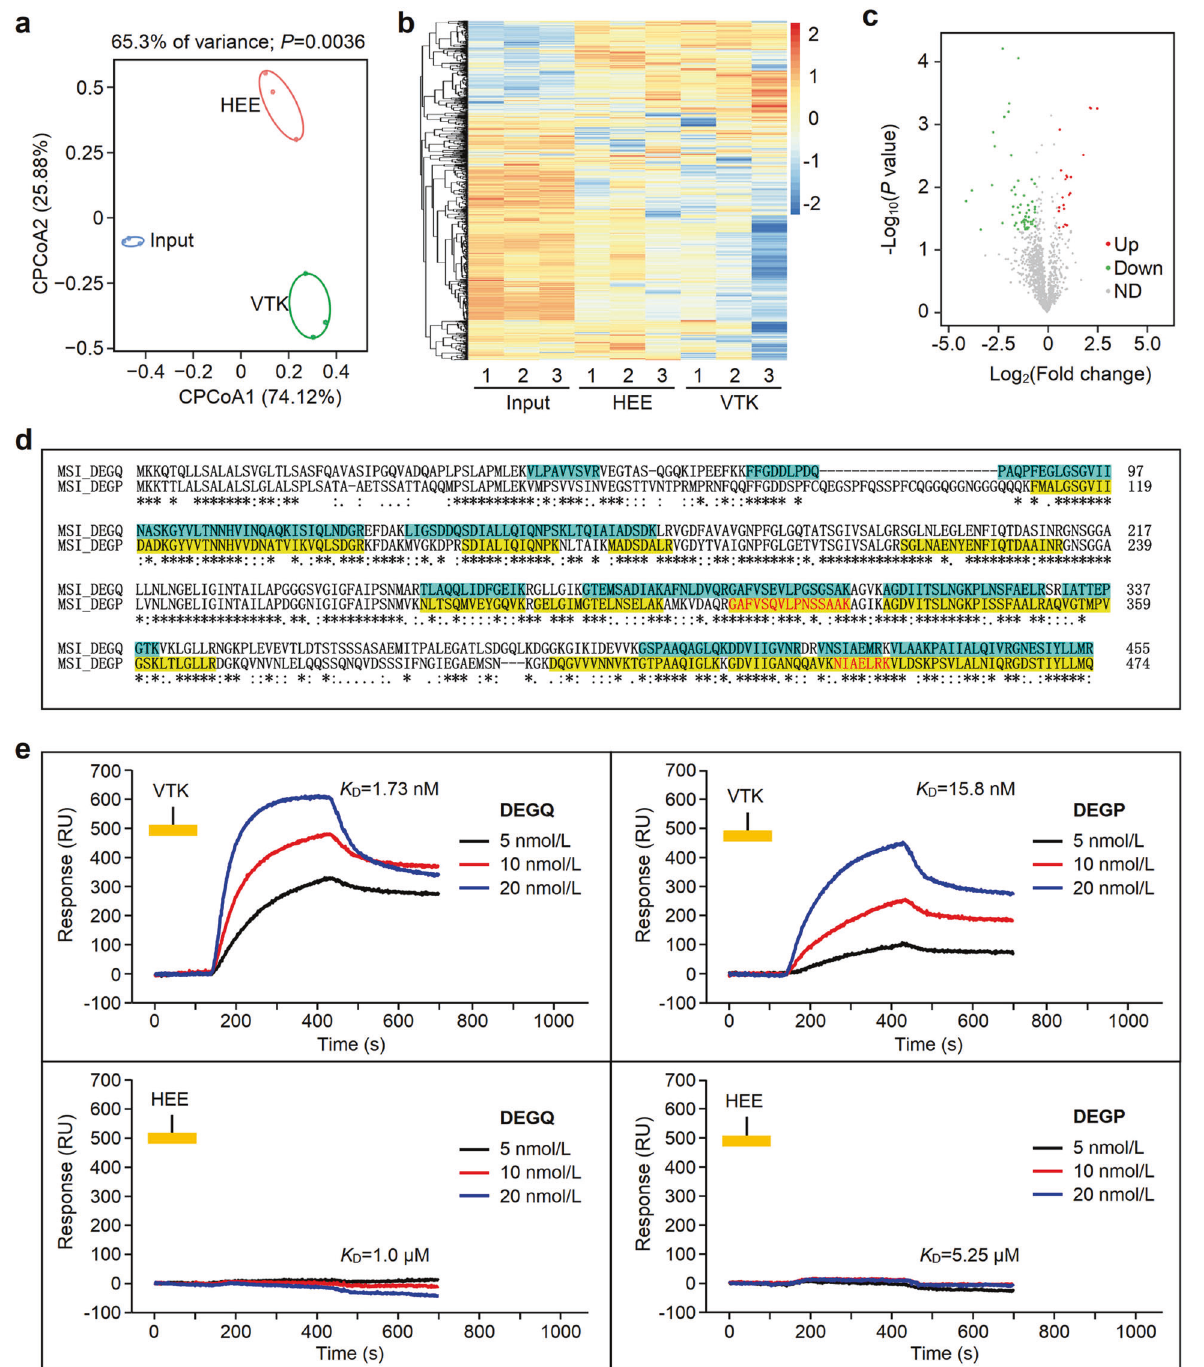
Fig. 8 Identi fi cation of VTK heptapeptide-targeted bacterial membrane proteins with label-free mass spectrometry. a Constrained principal coordinates analysis (cPCoA) plot. Protein pro fi les were determined by cPCoA distance among samples and characterized by close intragroup distances among samples. b Hierarchical clustering analysis of proteins from the HEE, VTK and input groups. The outer membrane proteins of MSI001 bacteria were digested with trypsin and pulled down by VTK or HEE heptapeptide as described in the Methods. Label-free mass spectrometry was used to quantitate proteins from the HEE, VTK and input groups. Red represents high expression, while blue represents low expression. c Volcano plot of proteins from the VTK group and HEE group. Red and green dots represent up- and downregulated proteins with |fold change (FC) | > 1.5 and P -value less than 0.05 compared to the control, respectively. d Protein sequence aliment of DEGQ and DEGP of E. coli MSI001 . The AAs with background color represent peptide fragments identi fi ed by mass spectrometry. e SPRi assay for the binding af fi nity between VTK peptide and DEGP or DEGQ protein. The synthesized VTK peptide (5 mmol/L, 10 µL) or HEE peptide as control was immobilized on an SPRi chip. DEGP or DEGQ protein at different concentrations (5 nmol/L, 10 nmol/L, 20 nmol/L) in solution fl owed on an SPRi chip. Binding data were collected and analyzed by commercial SPRi analysis software (Plexera SPR Data Analysis Model, Plexera, USA). The K D values were obtained via the BIAevaluation Software version 4.1